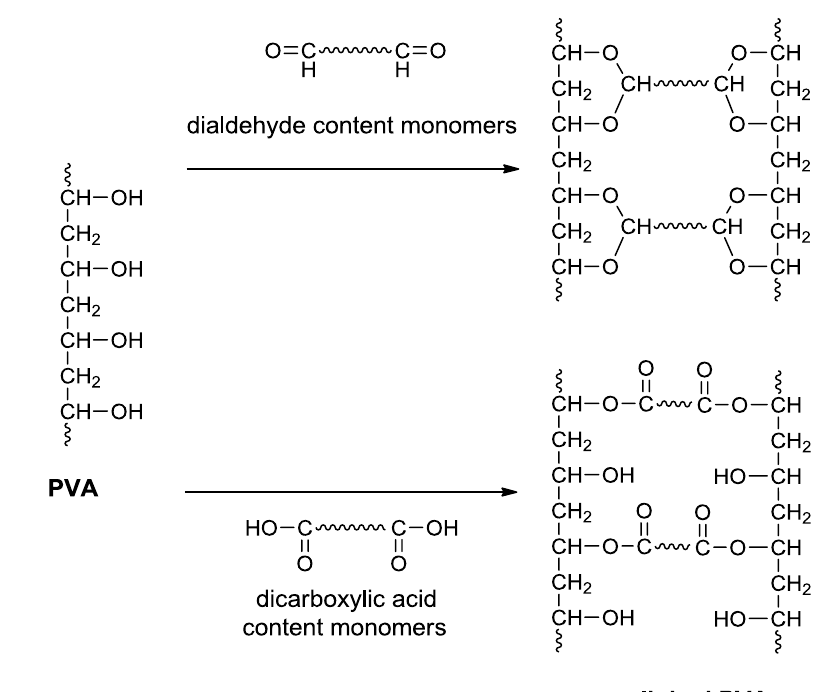
Figure 4. Scheme showing chemically cross-linked poly (vinyl alcohol) ( PVA)-based network